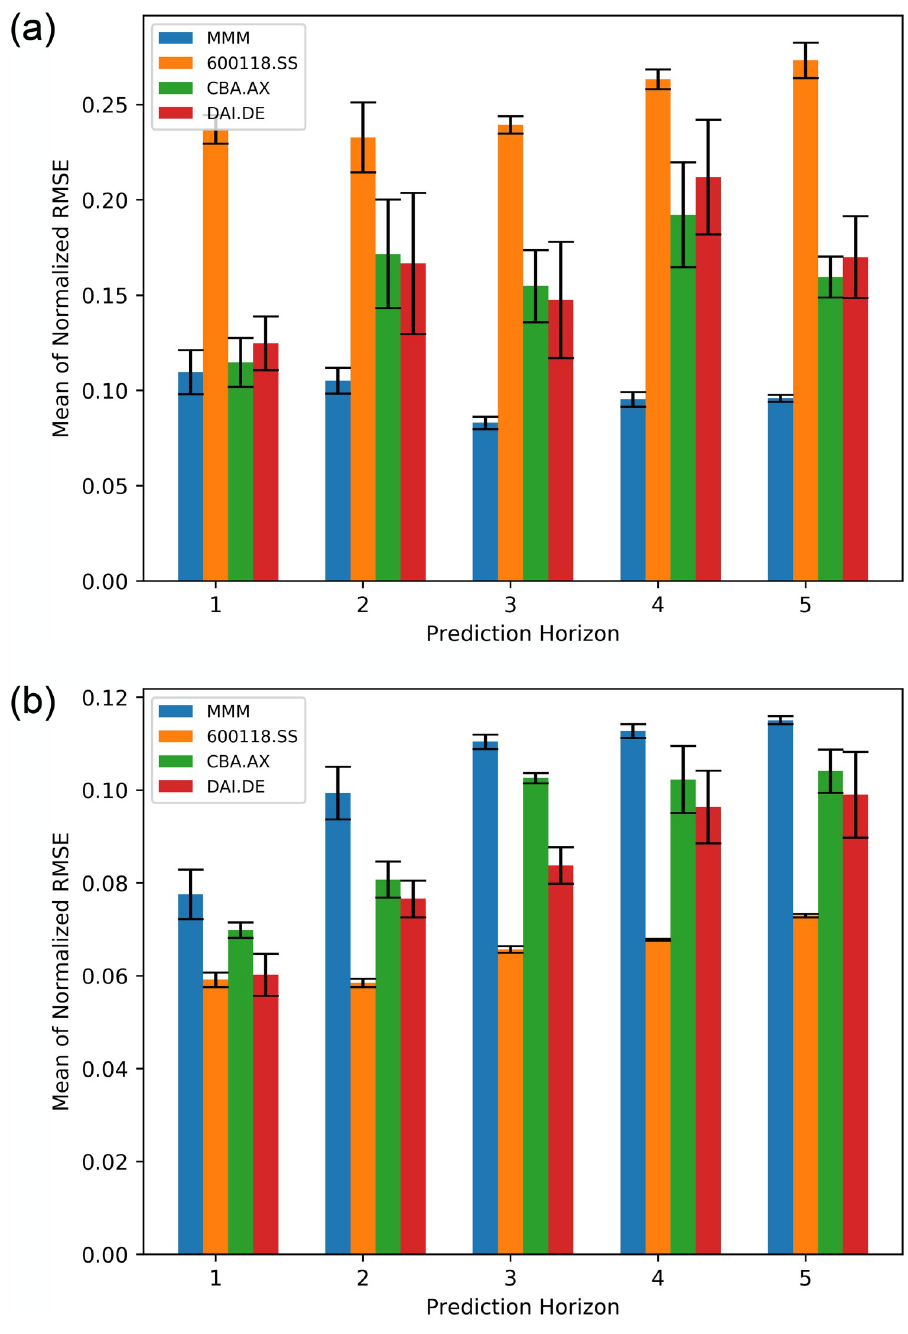
Fig 9. Prediction performance (mean of normalized posterior RMSE) of respective stocks during COVID-19 using Bayes-FNN (Setup 1 vs Setup 2). Note that the predictions were normalized in range of [0, 1]. changes in the stock [97]. The results during COVID-19 show that the uncertainty in the stock price is much higher due to the high volatility in the stock price. After training the model by adding part of data featuring high volatility (during COVID-19), the prediction accuracy of the model is greatly improved.